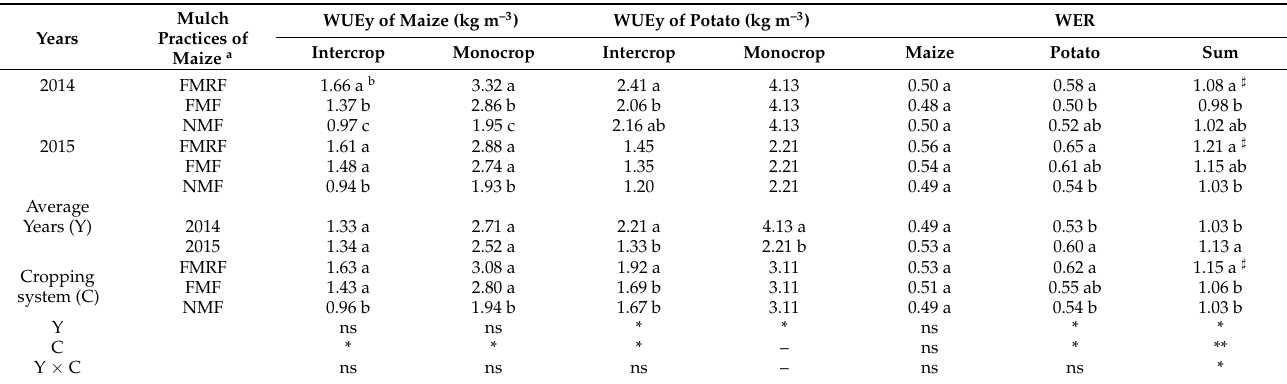
Table 7. Water use efficiency for yield and water equivalent ratio in maize/potato intercropping system compared with monocrop in